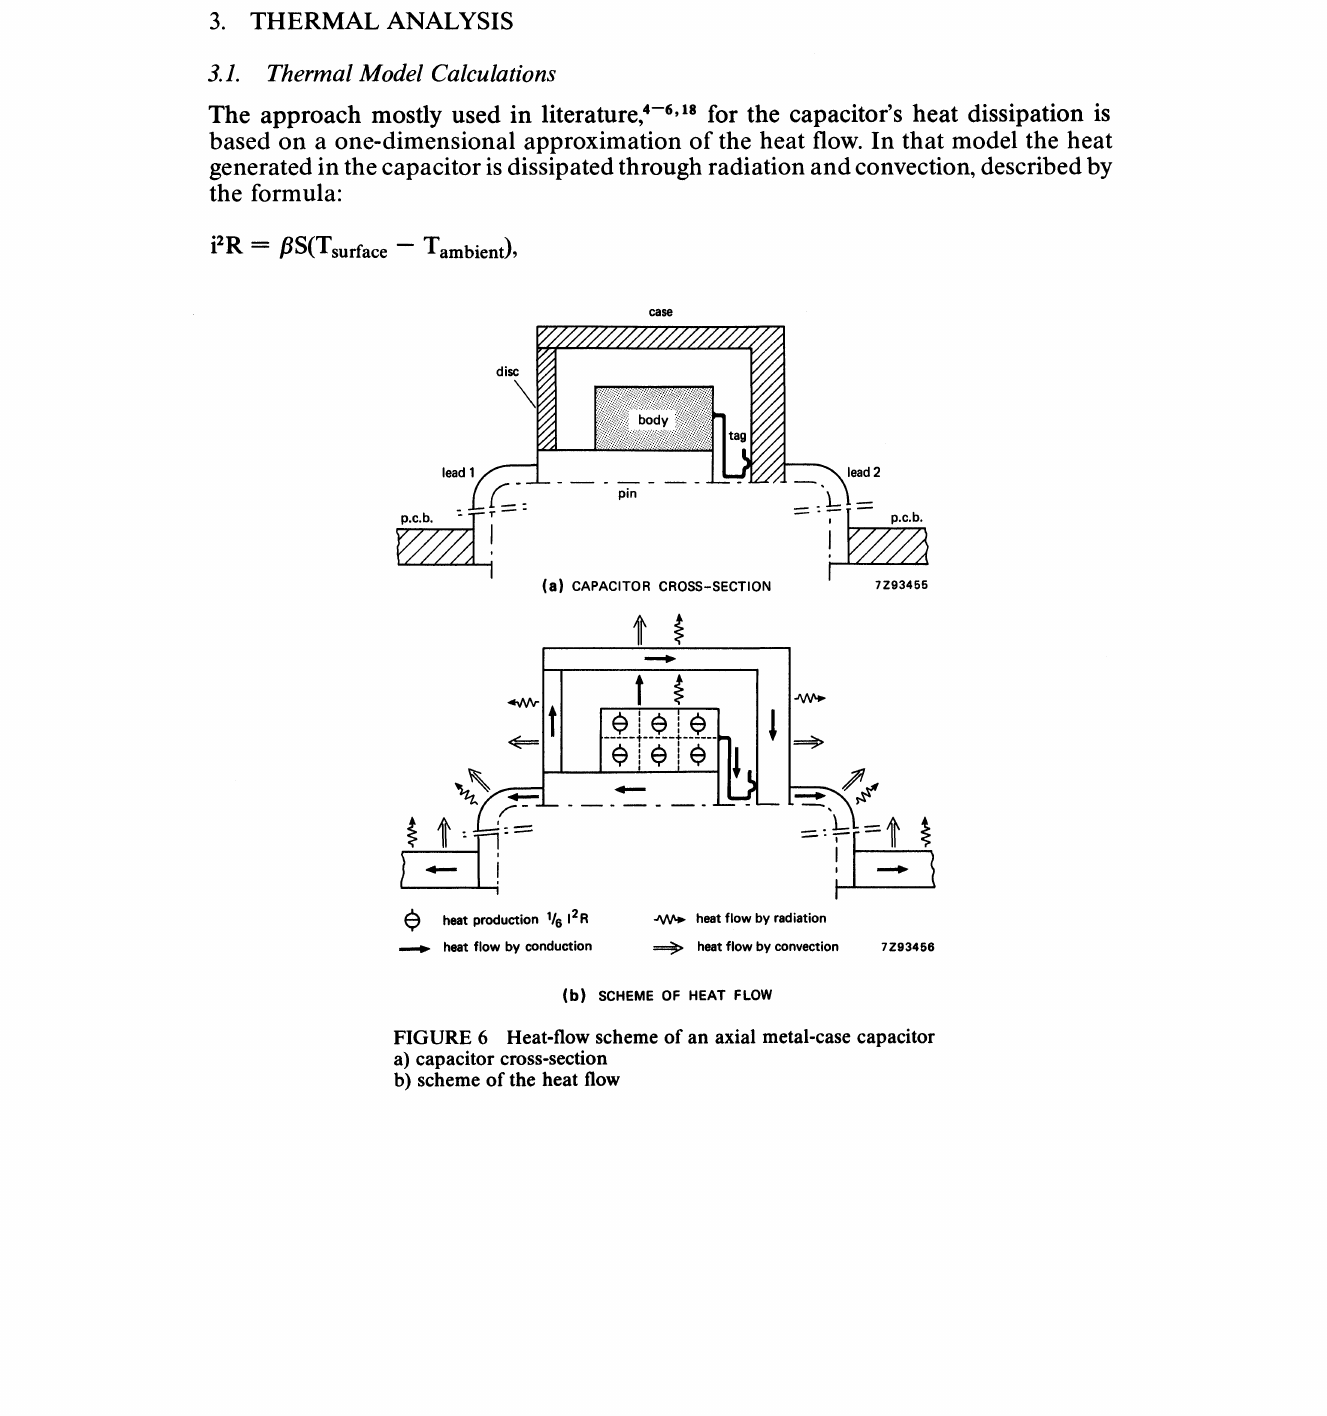
FIGURE 6 Heat-flow scheme of an axial metal-case capacitor a) capacitor cross-section b) scheme of the heat